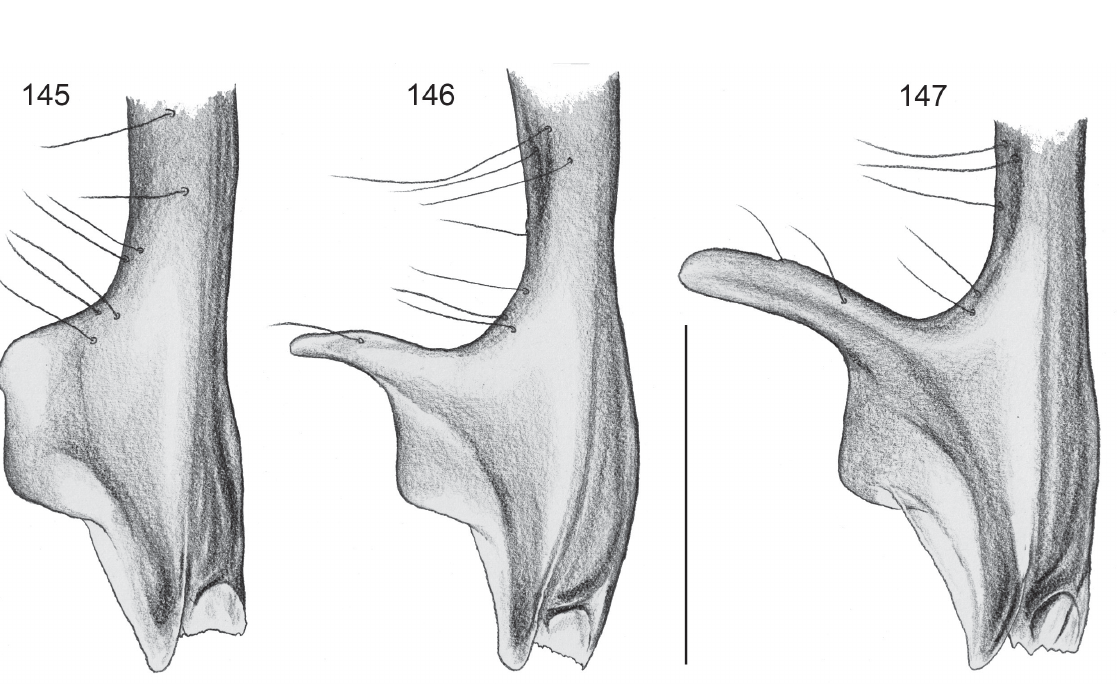
Figs 145–147. Pholcus domingo Huber sp. nov., tips of left procursi, retrolateral views. 145 . Dimapatoy (ZFMK, Ar 15728). 146 . Santo Domingo (type locality) (ZFMK, Ar 15720). 147 . Mt. Mupo (ZFMK, Ar 15727). Scale bar = 0.3